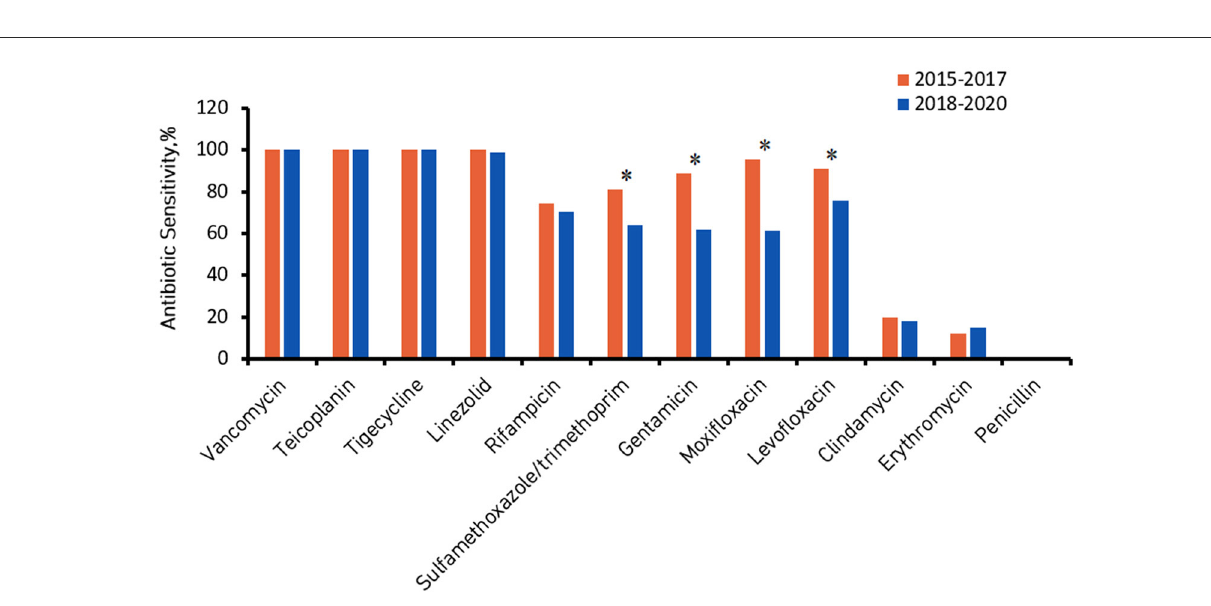
FIGURE3 Community-associated methicillin-resistant Staphylococcus aureus (CA-MRSA) antibiotic sensitivity from 2015 to 2017 compared with 2018 to 2020. * Denotes a significant difference in antibiotic sensitivity between 2015–2017 and 2018–2020 at P <